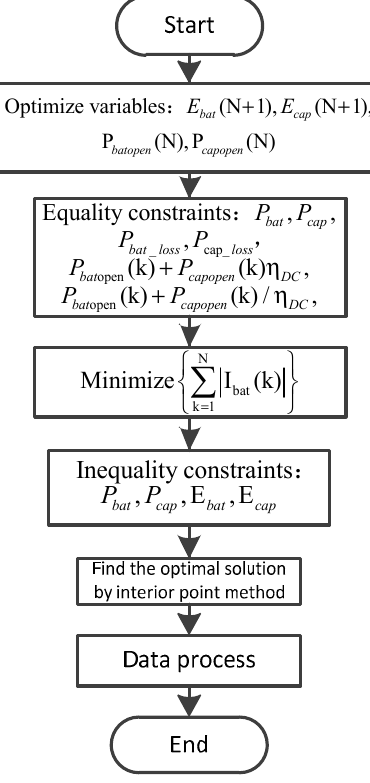
Figure 9. Convex optimization implementation flow.